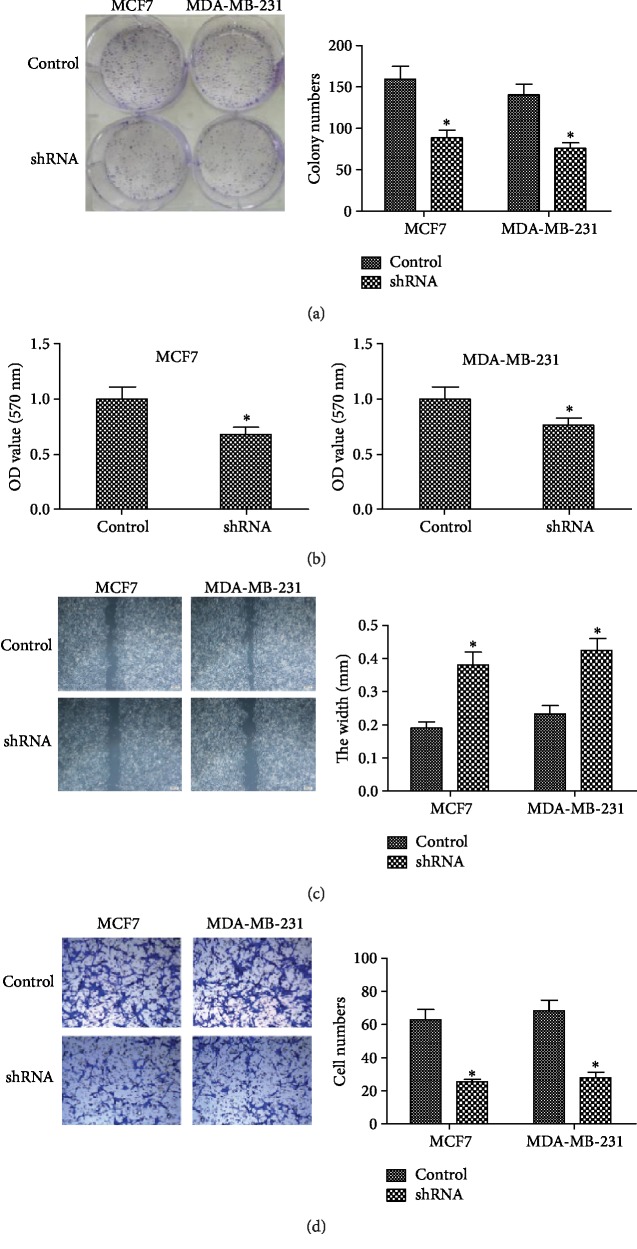
AK4 facilitates cell proliferation and invasion of HER2-positive breast cancer in vitro. (a) Colony formation assays were then performed using MCF7 and MDA-MB-231 cells transfected with control or AK4 shRNA plasmids, and colony number was counted. (b) The results of MTT assays showed the inhibition of cell proliferation caused by AK4 knockdown. (c) AK4 depletion resulted in the lower migration degree in MCF7 and MDA-MB-231 cells. Photographs showing that at the 0 and 24th-hour time point migrated cells were present. (d) Transwell assays using both MCF7 and MDA-MB-231 cells transfected with control or AK4 shRNA plasmids, and the degree of invasion was quantified by the invasion cell number. Results are presented as mean ± SD, ∗P < 0.05.